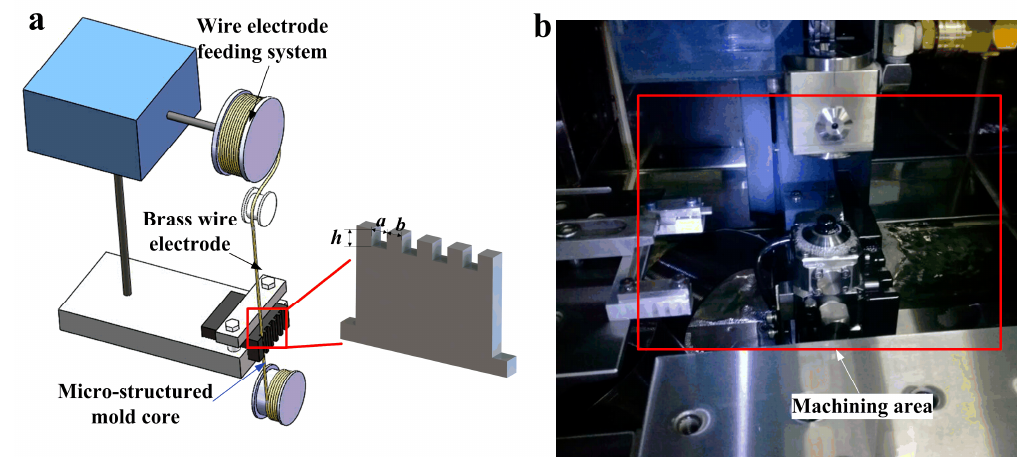
Figure 1. The processing schematic diagram of mold core machined by wire electrical discharge machining (WEDM): ( a ) schematic diagram of WEDM; ( b ) machining scene.